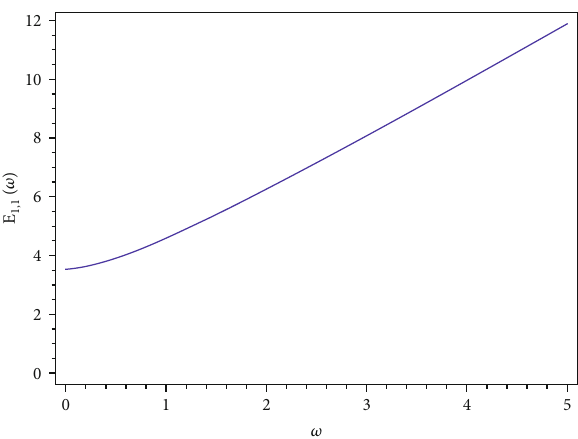
Figure 4: n = l = k = q = a = b = η